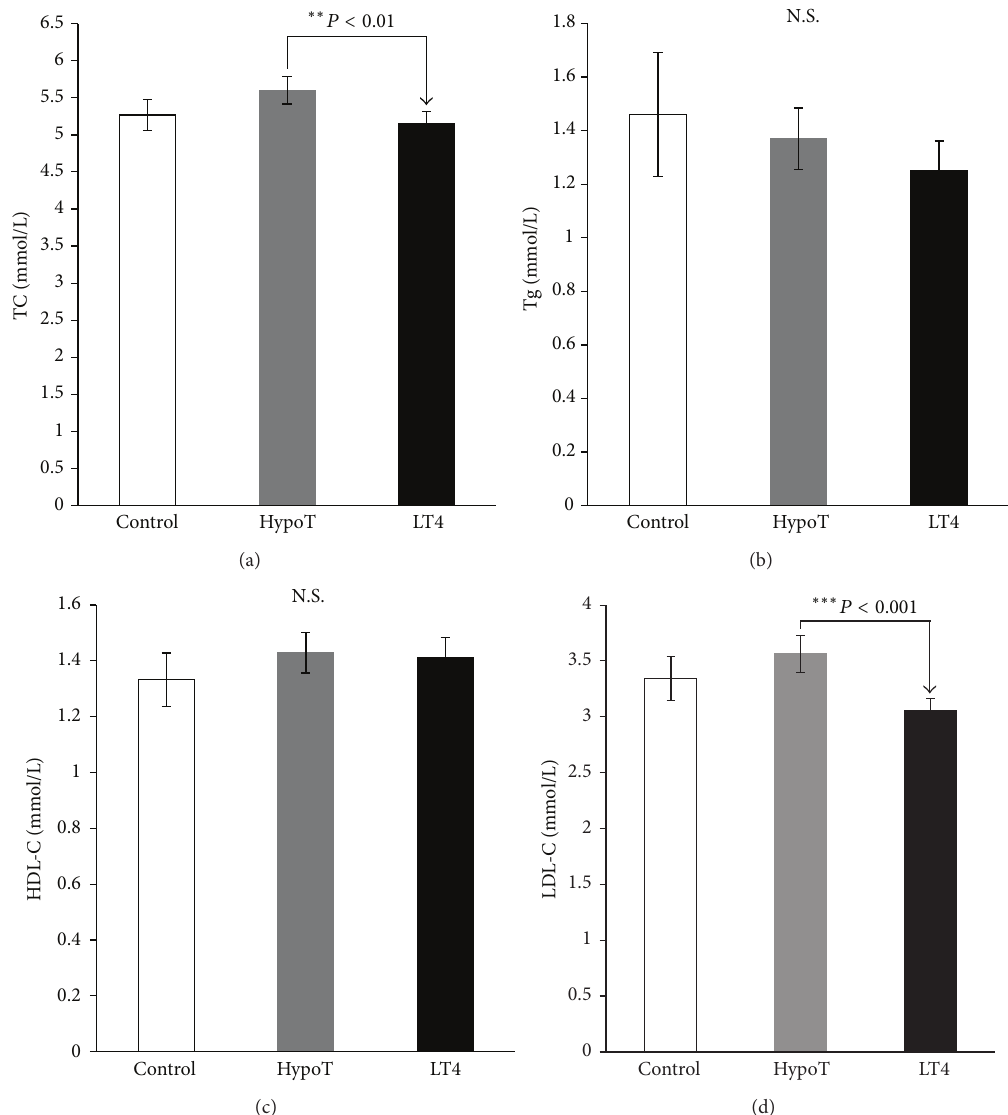
Figure2:Lipidprofiles:(a)totalcholesterol(TC),(b)triglyceride(Tg),(c)highdensitylipoproteins-cholesterol(HDL-C),and(d)lowdensity lipoproteins-cholesterol (LDL-C) of control and hypothyroid patients before (HypoT) and after treatment with LT4 (LT4). Values are given as mean ± SD. N.S.: